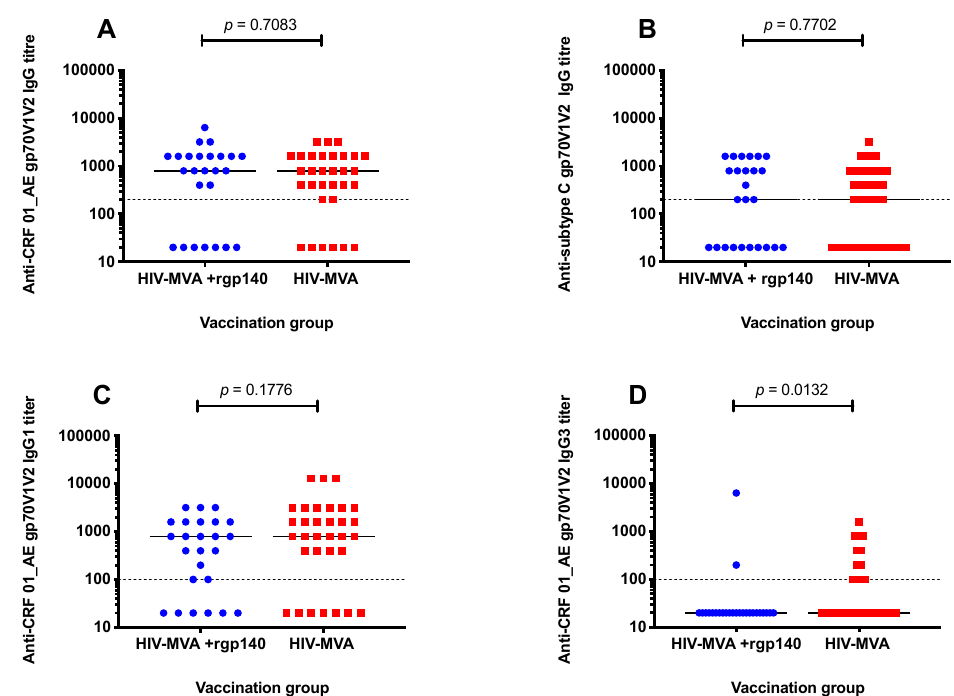
Figure 5. Binding total IgG antibodies to sca ff olded gp70V1V2 protein of CRF01_AE and subtype C and IgG1 and IgG3 antibodies to sca ff olded gp70V1V2 protein of CRF01_AE in plasma samples from a subset of vaccinees ( n = 57). The Mann–Whitney test was used to compare the magnitude of V1V2 specific antibody responses between the two vaccination groups. There was no significant di ff erence between the two vaccination groups in the magnitude of total IgG responses to CRF01_AE ( A ) or subtype C ( B ) V1V2 protein. No significant di ff erence in the magnitude of anti-V1V2